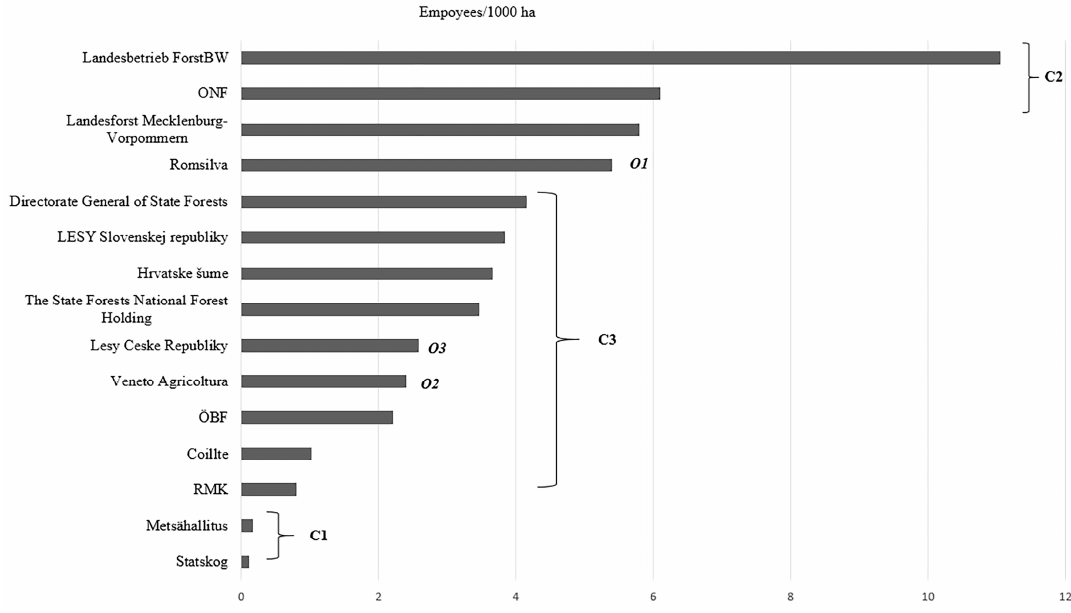
Figure 5. Labor productivity in SFMOs (own elaboration).